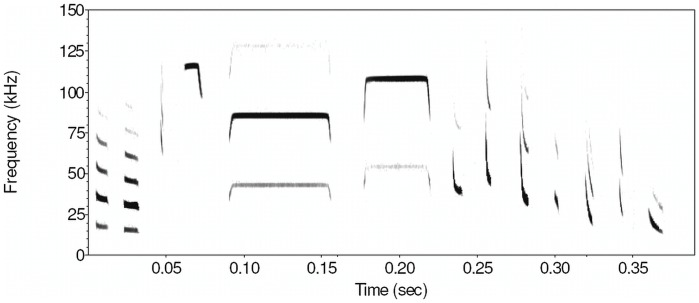
Spectrogram of one typical echolocation call from each identified species.From left to right: Rhinopoma hardwickii, R. microphyllum, Nycteris thebaica, Asellia tridens, Rhinolophus hipposideros, R. clivosus, Pipistrellus kuhlii, Hypsugo bodenheimeri, Eptesicus bottae, Barbastella leucomelas, Otonycteris hemprichii, Plecotus christii and Tadarida teniotis. Spectrogram parameters: FFT 1024, frame 100%, overlap 98.43%, window flat top.